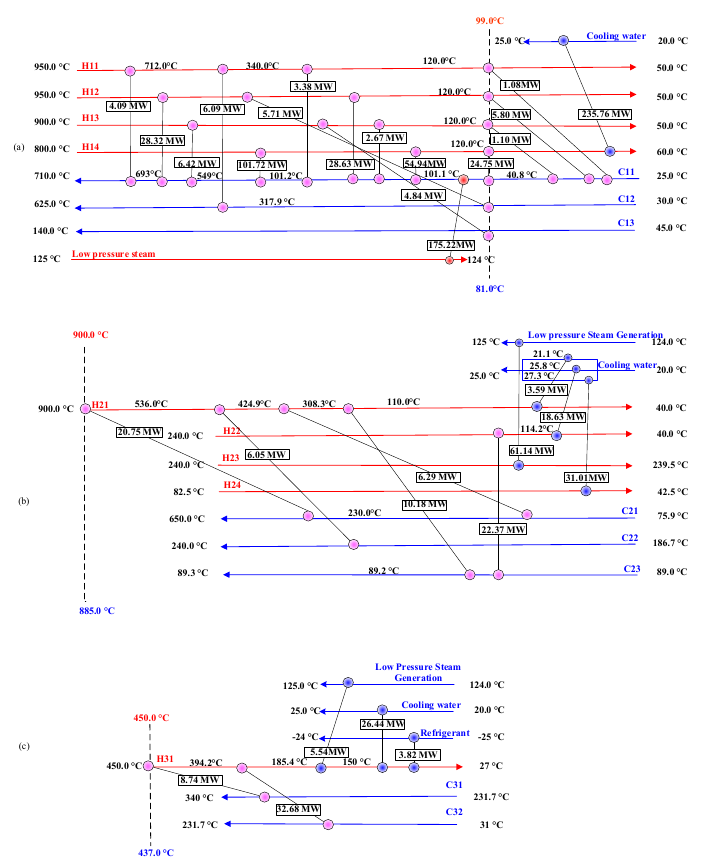
Figure 4. Grid diagram of HENs for ( a ) CLHG + COMB, ( b ) DRU + MSU, and ( c ) APU. The costs of HENs for CLHG + COMB are summarized in Table 3; the operating cost of the heat exchange unit was USD 12.64 million/year, the capital cost was USD 47.160 million, and the TAC was USD 18.85 million/year. Table 3. Cost of HEN.